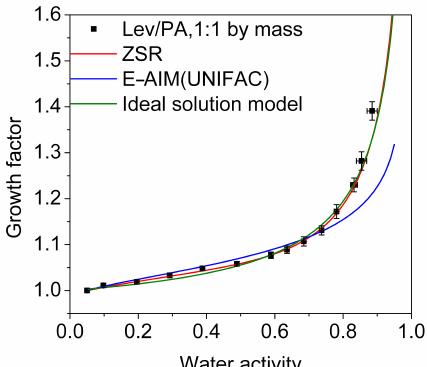
Figure 5. Hygroscopic growth factors of aerosols consisting of lev- oglucosan and phthalic acid (Lev / PA) at a mass ratio of 1:1 as a function of water activity. Initial particle diameter is about 100nm. Predictions based on the ZSR, E-AIM (UNIFAC), and ideal solution model are also included. The uncertainty in our measured growth factors is within